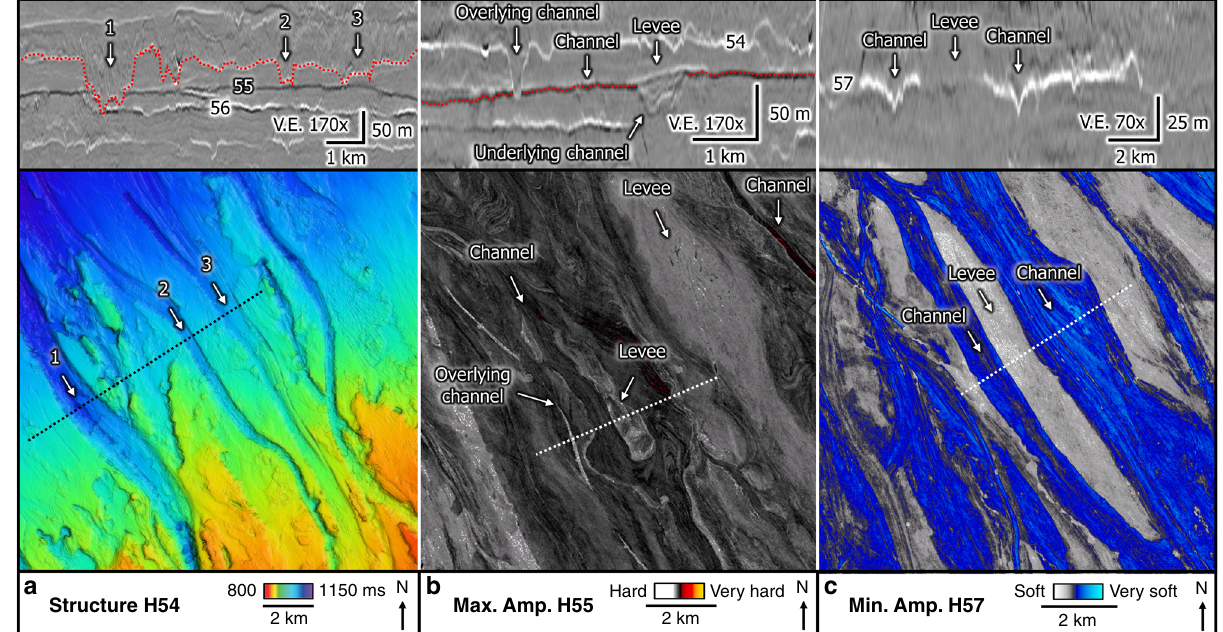
Fig. 4 Examples showing the detailed morphology of channels, using zoomed seismic pro fi les, structure, and horizon attribute maps. a Deeply eroded, wide channels on Horizon 54 (red line). Channel 1 crosscuts underling Horizons 55 and 56. b Channel-levee system on Horizon 55 (red line). The overlying channel (Horizon 54) is eroding into Horizon 55. Channels have harder amplitudes than levees. c Link between channels (in fi ll) and levees on Horizon 57. The channels have high negative amplitudes (very soft), whereas the elongated levees have low negative amplitudes (soft). The location of the maps is shown in Fig. 2a and the stratigraphical position of the different horizons in Fig. 3. V.E. vertical exaggeration. For detailed interpretation of seismic pro fi les, see Supplementary Fig. 4. Seismic data courtesy of